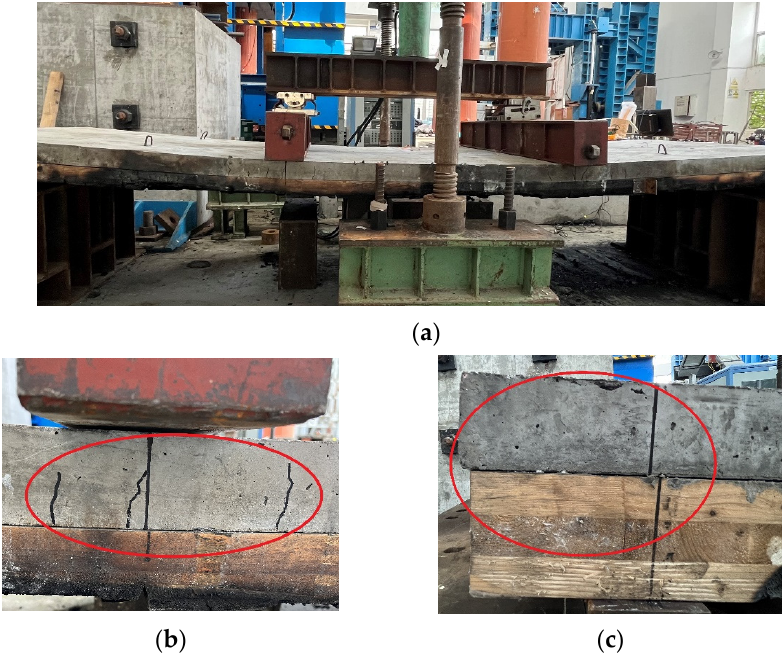
Figure 12. ( a ) Bending deformation in the elastic stage; ( b ) vertical crack in the concrete; and ( c ) interfacial relative slip.